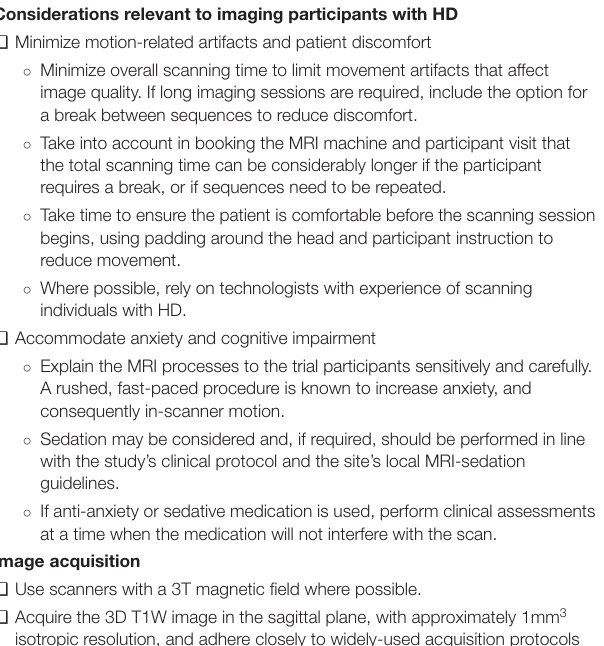
TABLE 1 | Recommendations for the use of vMRI in HD clinical